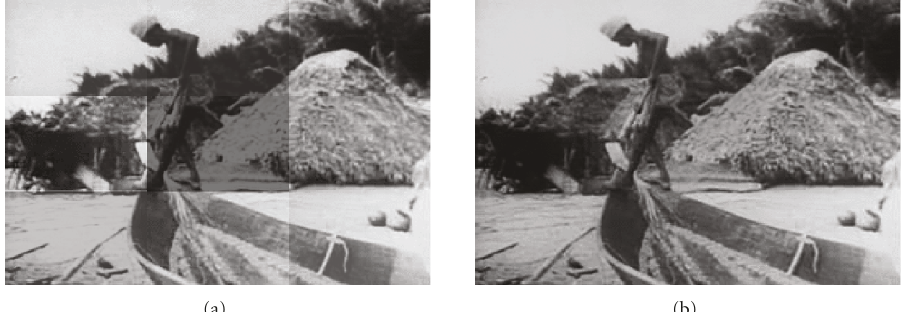
Figure 8: (a) Compensation of the frame 20 of the test sequence Boat applied independently on each block of a 3 × 3 grid. As expected blocking artefacts are visible. (b) Compensation using the spatially adaptive version of the algorithm.